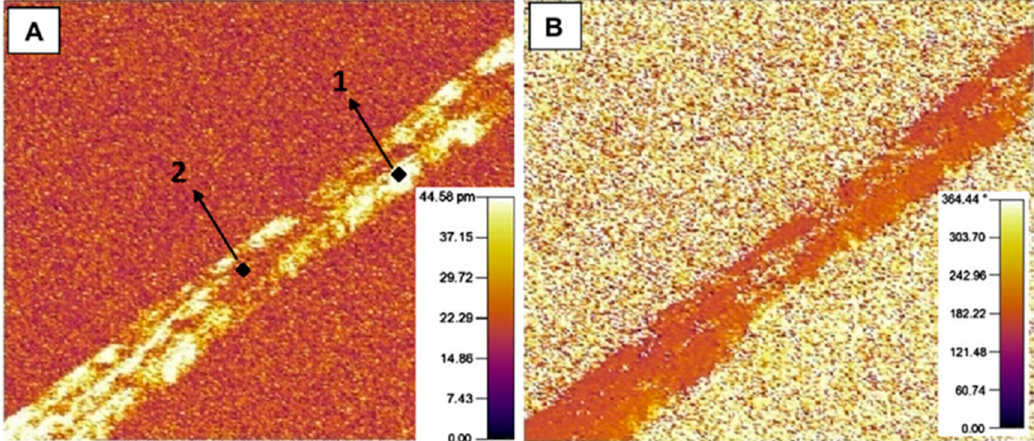
Figure 4. ( A ) Piezoelectric force microscopy (PFM) amplitude image. ( B ) PFM phase image [152]. The sample size is 4 μ m × 4 μ m (Two points on the fiber refers to those selected by the authors to measure the piezoresponse at selected localized regions. Point 1 is located at a region which shows a bright contrast while Point 2 is at a region which has a dark contrast in the PFM amplitude